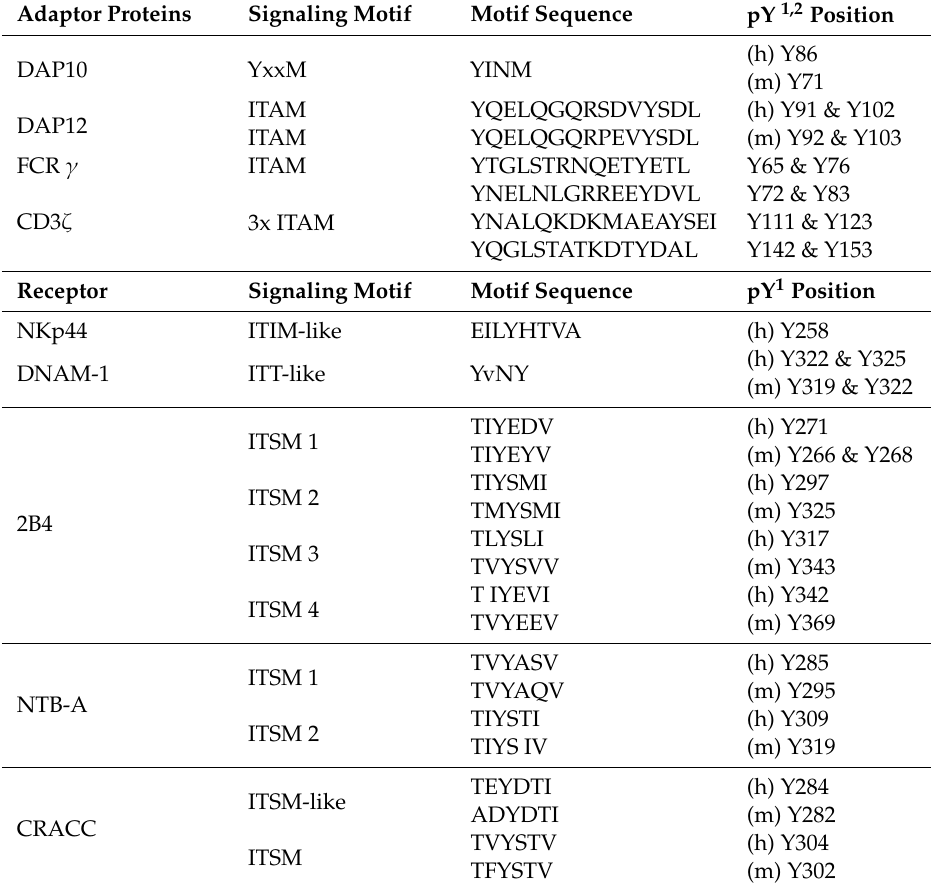
Table 5. Activating signaling